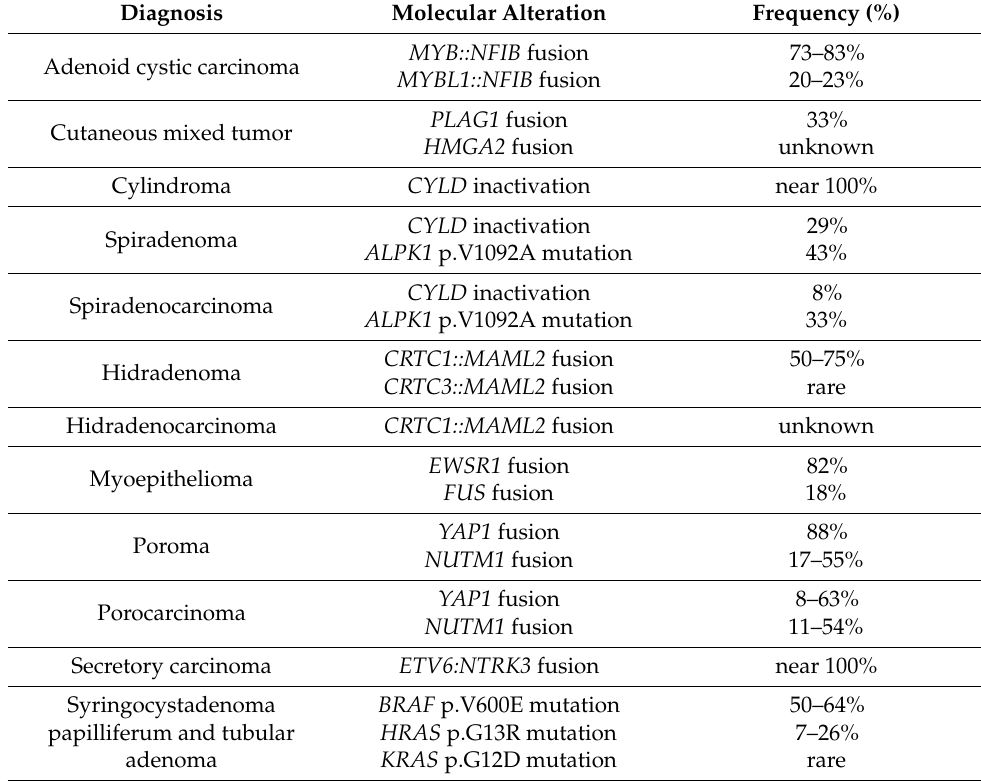
Table 2. Summary of the most frequent molecular alterations in sweat gland